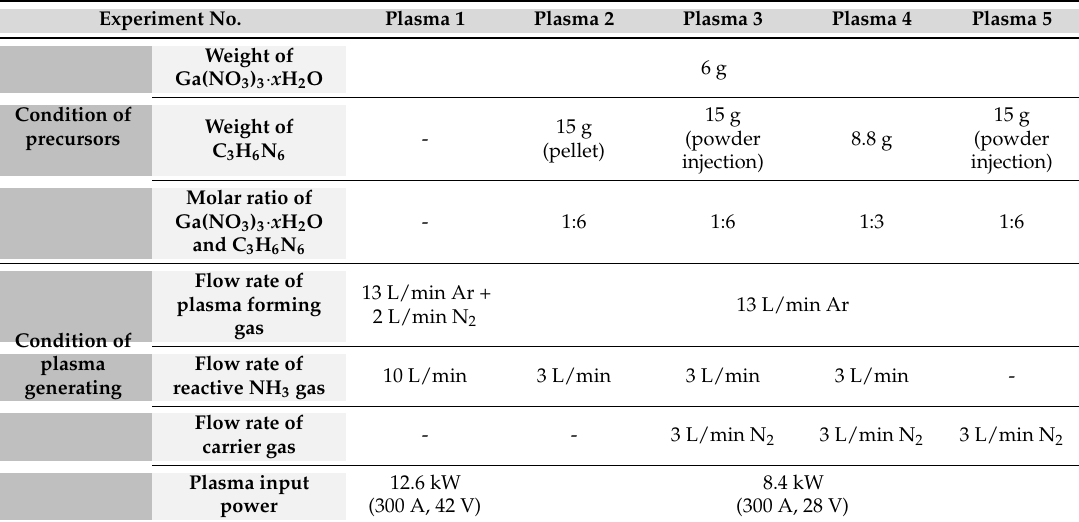
Table 1. Operating conditions for the synthesis of GaN powder by thermal plasma.